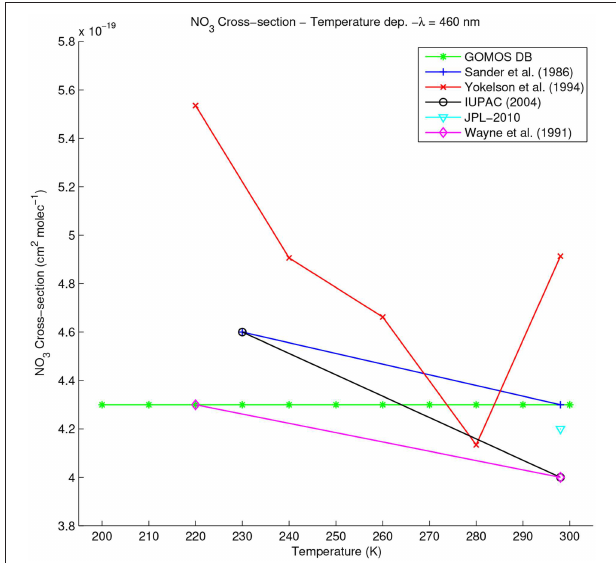
FIGURE 9 | Temperature dependence of the NO 3 absorption cross-section at 460 nm for all available